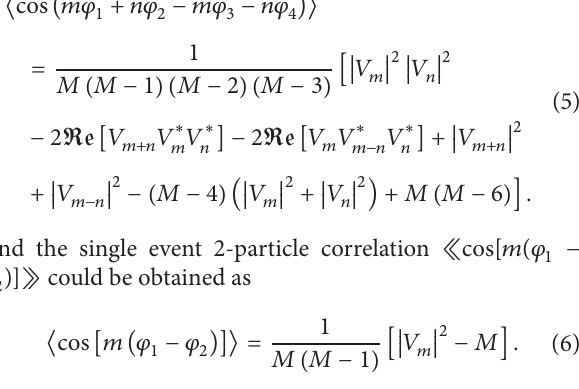
are averaged to zero. The single event 4-particle correlation + 𝑛𝜑 − 𝑚𝜑 − 𝑛𝜑 ) ) could be calculated ( cos (𝑚𝜑 1 2 3 4